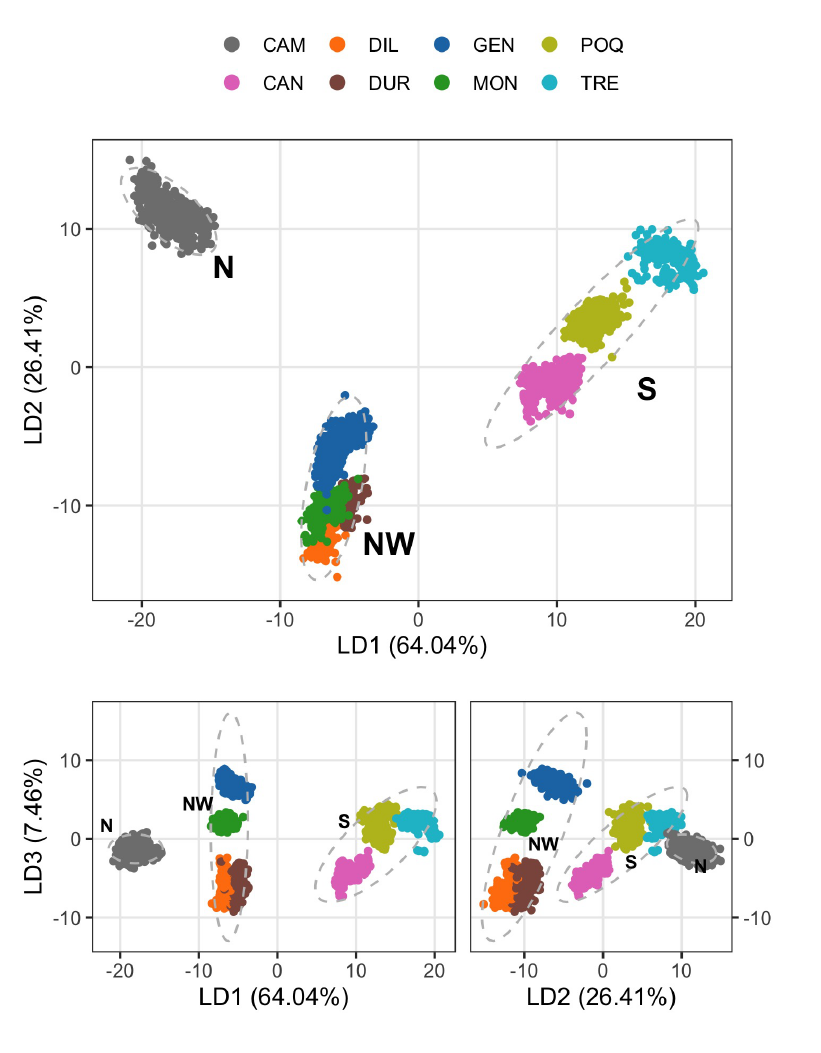
Figure 3. Discriminant analysis ordination of Quercus pyrenaica populations. N: northern population group (CAM); NW: northwest population group (GEN, MON, DUR, DIL); and S: southern population group (CAN, POQ, TRE). Population’s code as in Table 1. Numbers in brackets expressed explained variance (%) for each discriminant